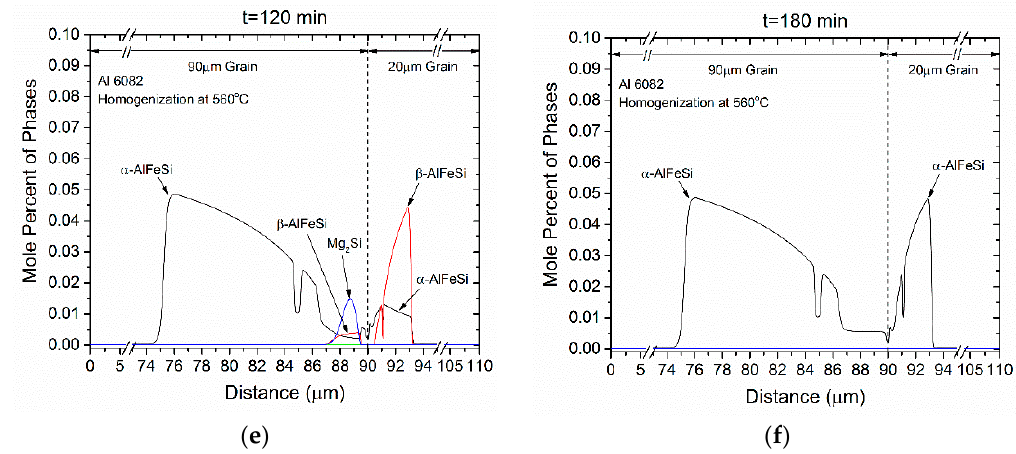
Figure 7. Spatial evolution of α -AlFeSi, β -AlFeSi, Mg 2 Si and Si (diamond) during homogenization at 560 °C of 6082 alloy: ( a ) As Cast, ( b ) 15 min, ( c ) 30 min, ( d ) 60 min, ( e ) 2 h (120 min), and ( f ) 3 h (180 min).